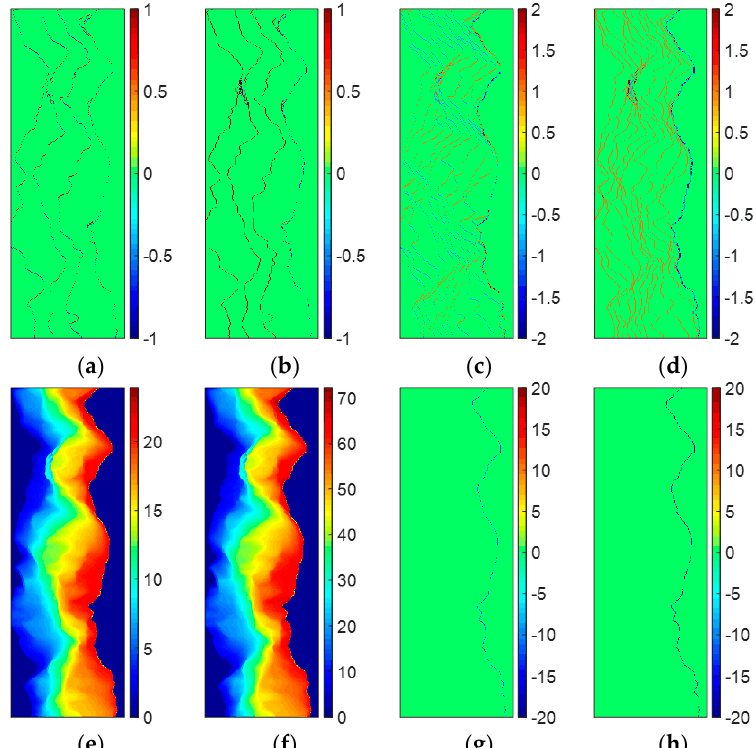
Figure 4. ( a , b ) Vertical and horizontal neighboring ambiguity number differences of Figure 1c. ( c , d ) Vertical and horizontal neighboring ambiguity number differences of Figure 1d. ( e ) PU results of Figure 1c obtained by TSPA-PUMA. ( f ) PU results of Figure 1d obtained by TSPA-PUMA. ( g ) Errors between Figure 1a and PU results ( e ). ( h ) Errors between Figure 1b and PU results ( f ).